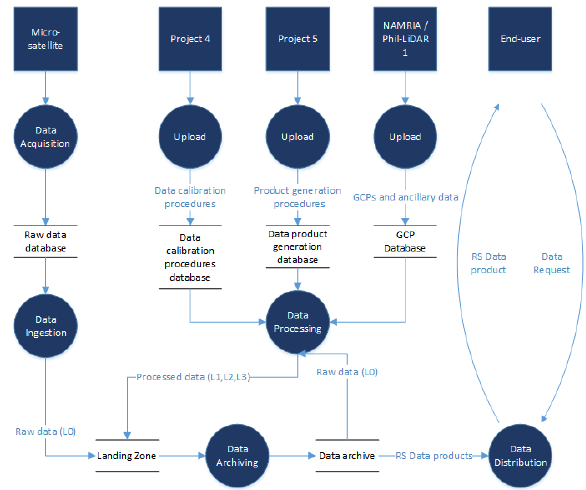
Figure 2 Overview of the system architecture and data